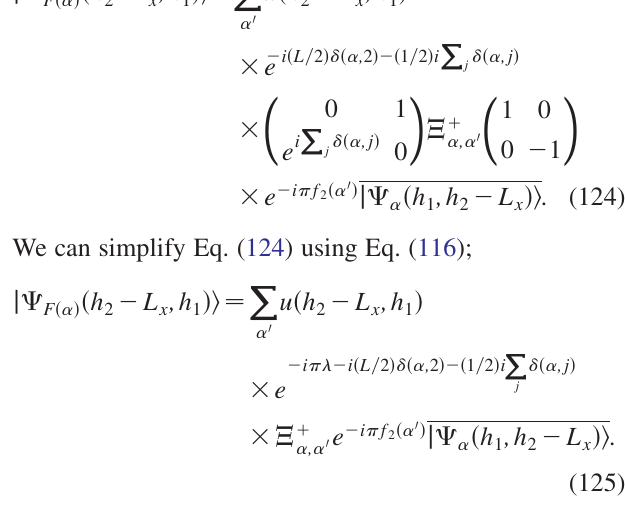
are underlined. i